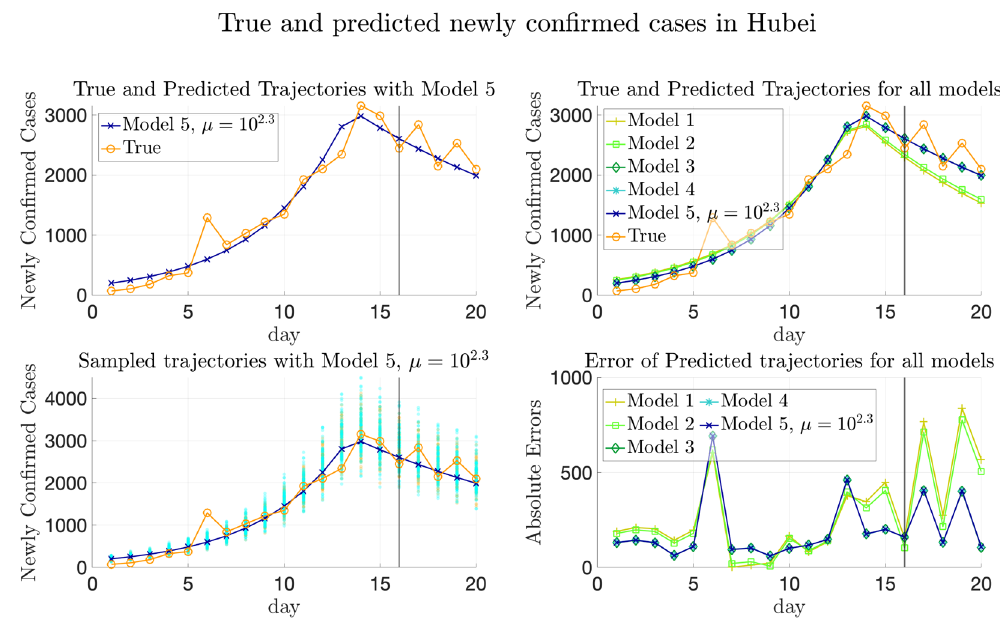
Figure 8. True and fitted trajectories in Hubei. The orange line with circles shows the true trajectory, the blue lines with crosses show the predicted deterministic trajectories using Model 5, blue and orange scatter plots show 100 stochastic trajectories with (cid:31) ∗ inferred using Model 5 and sampled from the posterior distribution of (cid:31) respectively. In each figure, the black vertical line shows the threshold of training-testing split. For Model 5, µ ∗ = 10 2.3 is chosen, at which the validation errors achieves the minimum value, marked by blue squares in Fig. 12 and Supplementary Fig. S5.